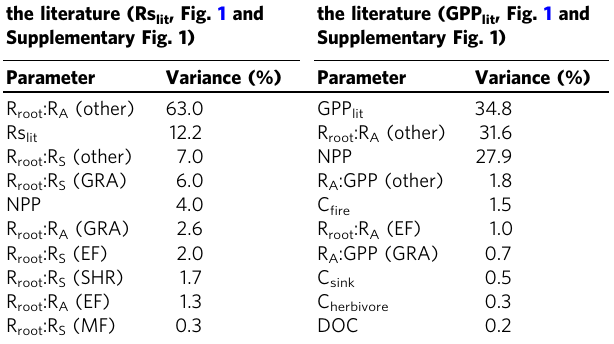
Table 1 Variance decomposition for the calculation of gross primary productivity (GPP) from soil respiration (R S ) reported in the literature (Rs lit ), and calculation of R S from literature GPP (GPP lit